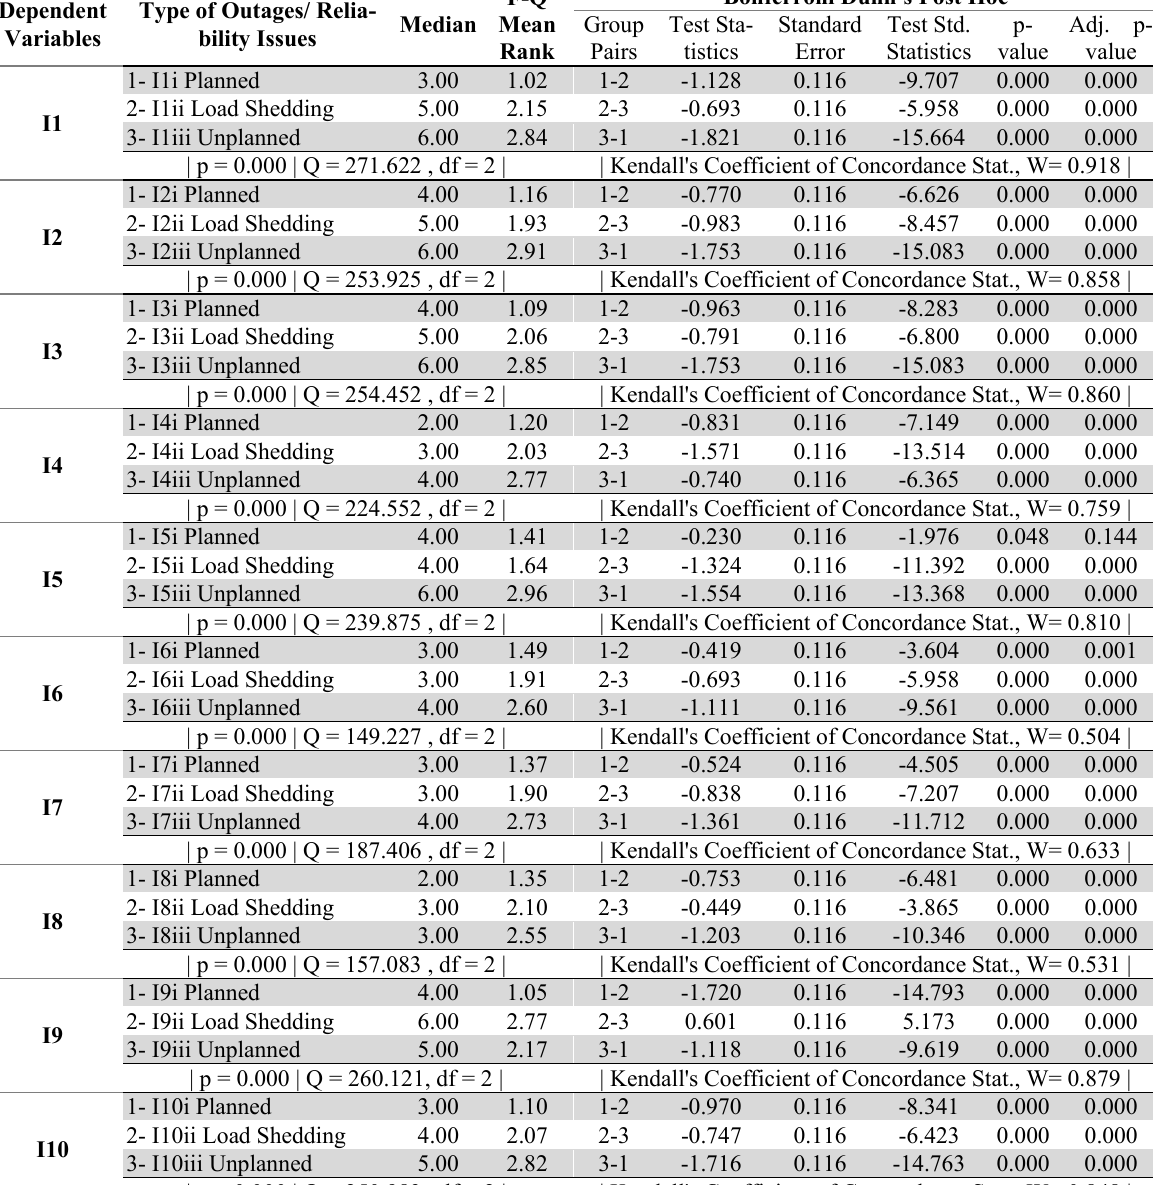
Friedman Q statistics- Level of effect by different reliability issues on future plans and strategies Dependent Type of Outages/ Variables